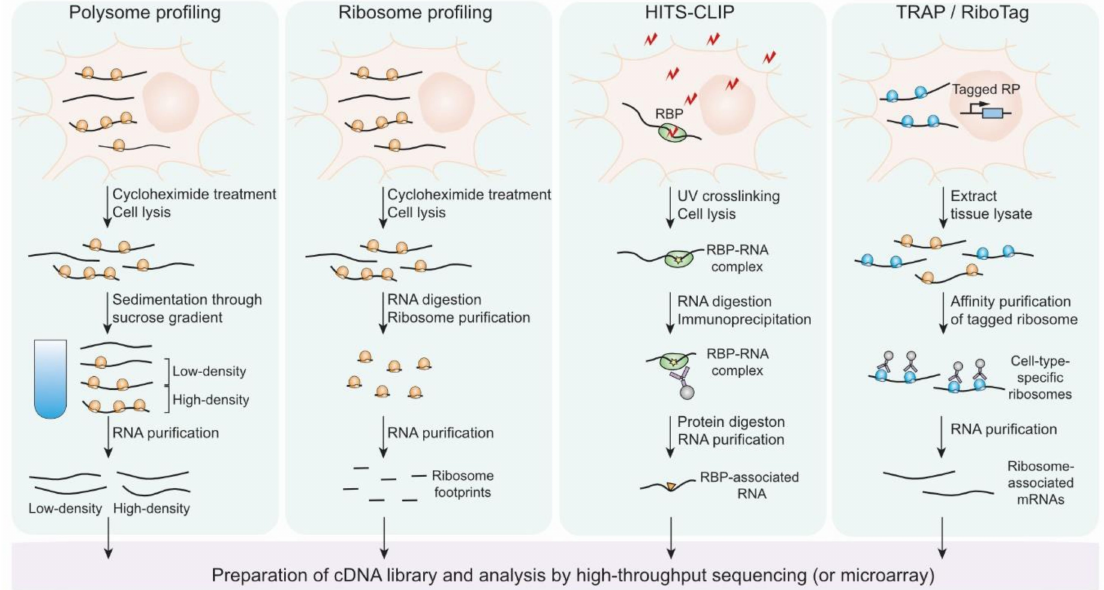
Figure 3. Schematic presentation of genome-wide methods to study translational controls in